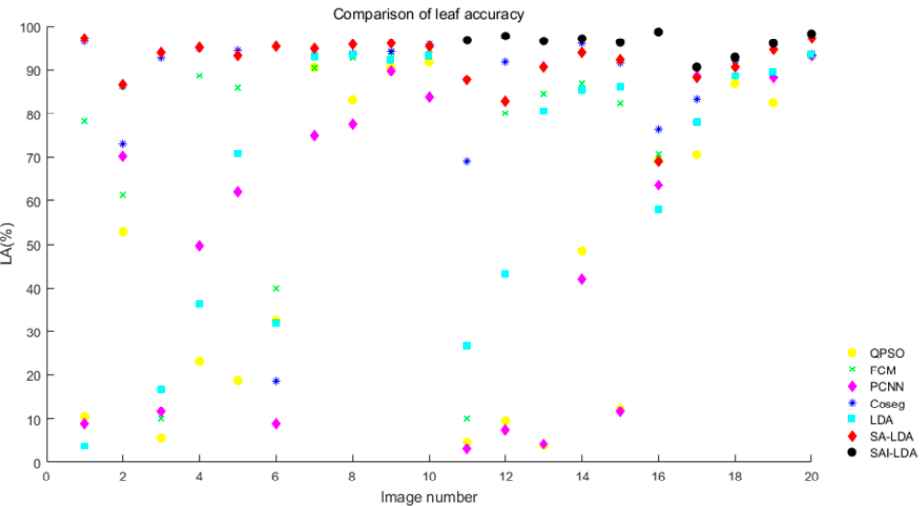
Figure 22. The result of leaf accuracy with different algorithms.